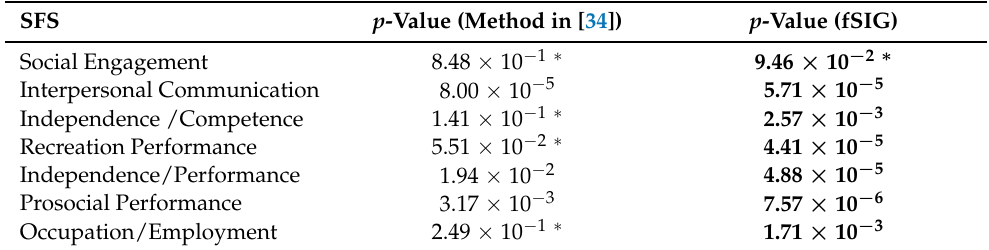
Table 3. Two-sample t -test of each field included in SFS (lower p -value is marked in bold and non-significant values are marked with ∗ ).